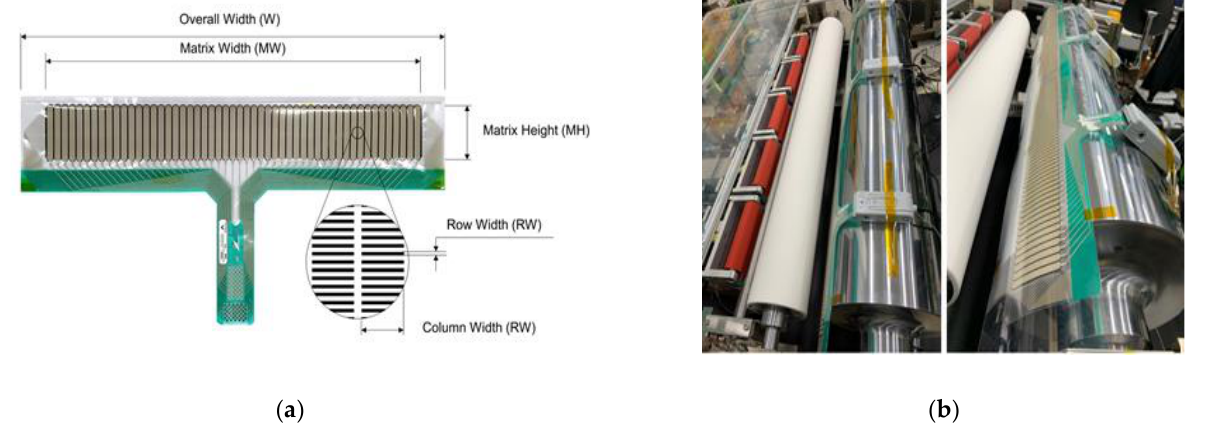
Figure 8. Large-area R2R uniform pressing system used in experiments: ( a ) Electronic pressure measurement sensor; ( b ) Setup of electronic pressure measurement sensors on large-area R2R uniform pressing system.